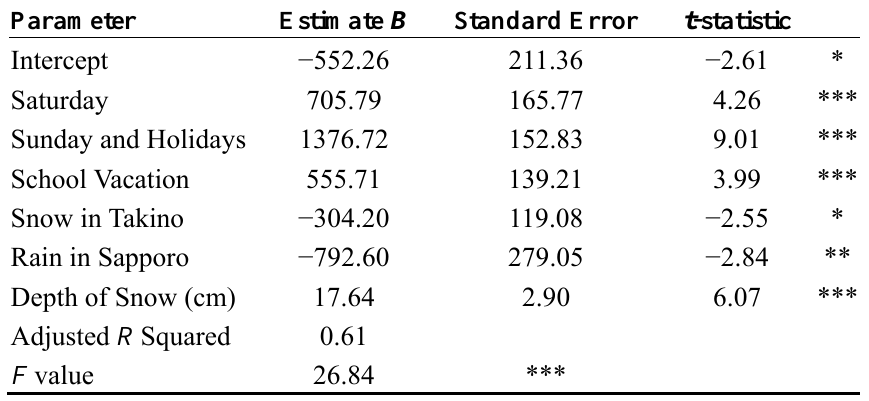
Table 6. Regression analysis for the number of visitors in the snow season in FY 2005.